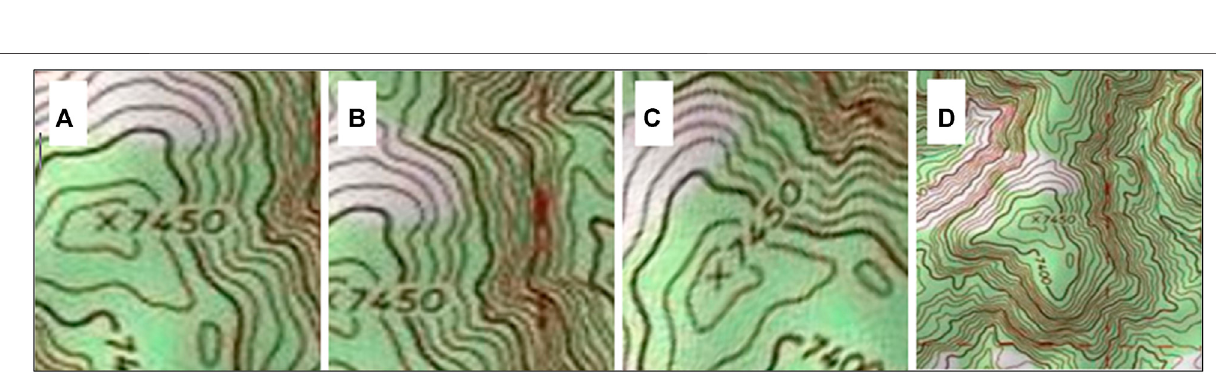
Frontiers in Environmental Science |